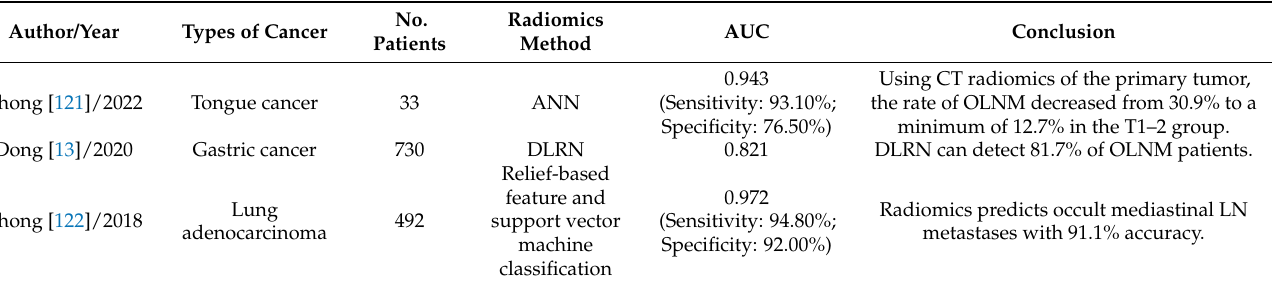
Table 4. Predicting OLNM in patients with different cancers using